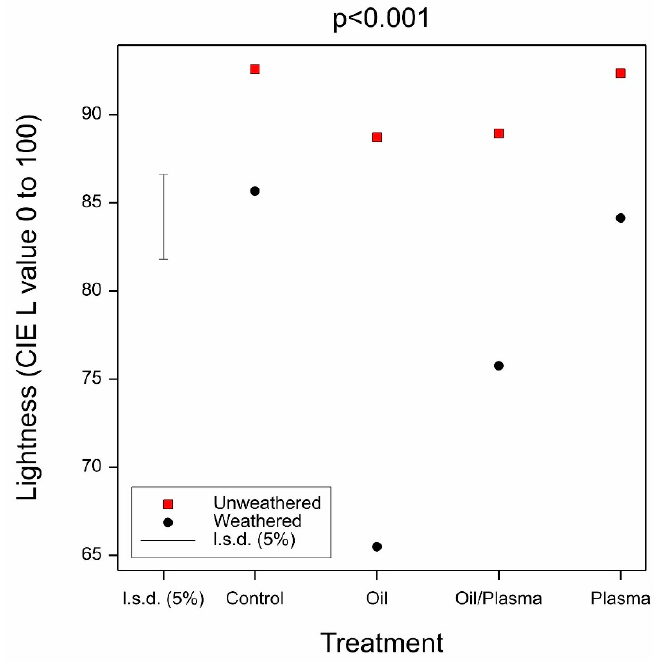
Figure 5. Effects of hot-oil treatment and/or plasma modification on the white colour (CIE L value) of an acrylic paint on blue-stained lodgepole pine samples exposed to 18 months of natural weathering.